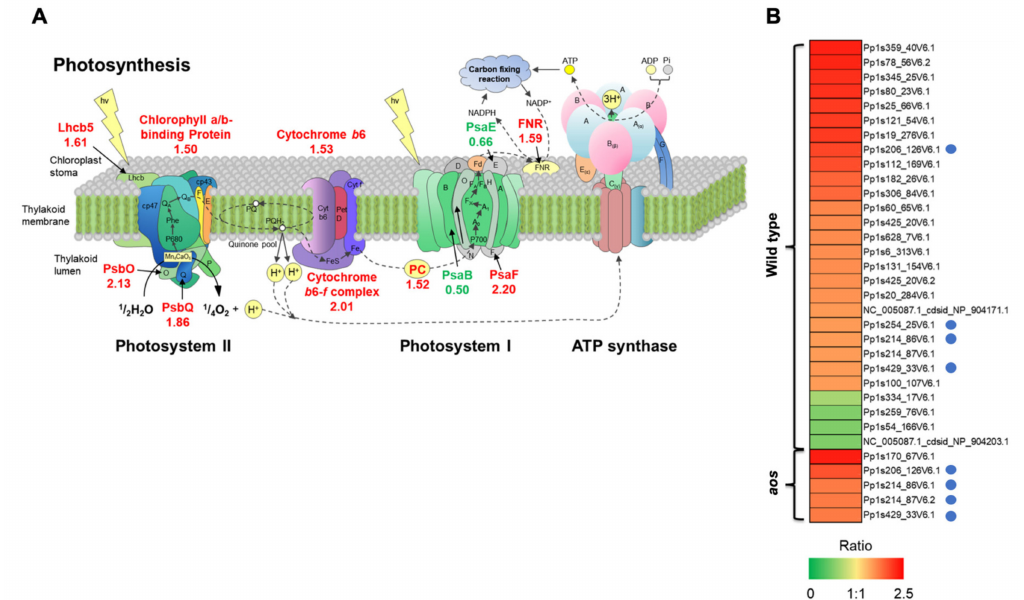
Figure 6. Di ff erentially accumulated proteins involved in photosynthesis. ( A ) Proteins involved in photosynthesis were di ff erentially accumulated in response to wounding stress in wild-type P. patens . Red and green numbers represent the relative abundance of proteins related to photosynthesis in response to wounding in the wild-type. Lhcb5 (Pp1s628_7V6.1, Pp1s6_313V6.1), light-harvesting complex II protein Lhcb5; chlorophyll a / b-binding